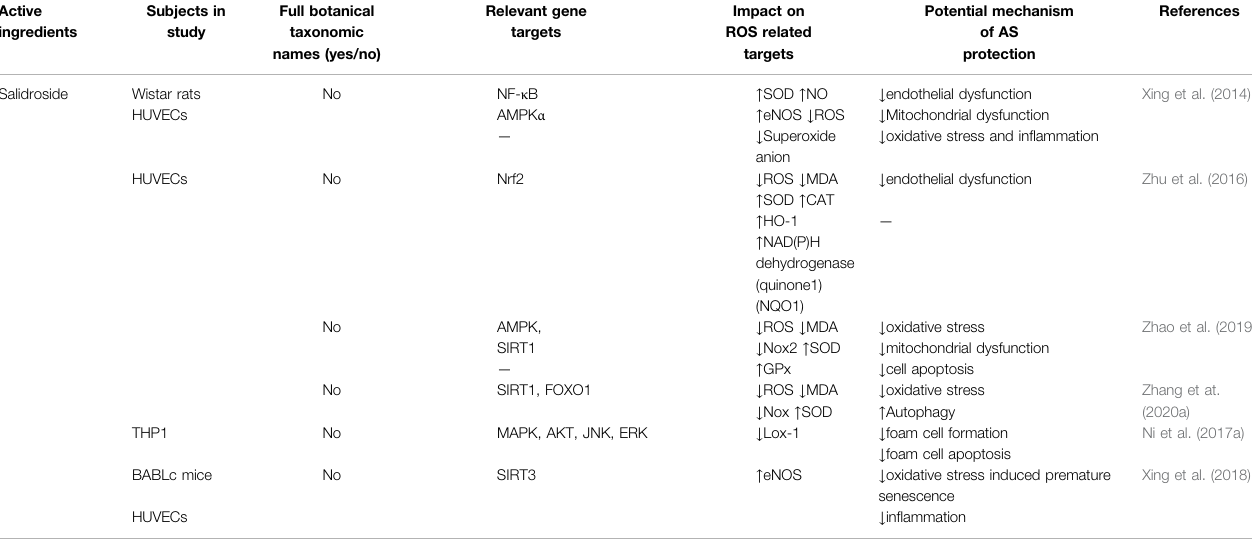
TABLE 3 | Salidroside for treatment of atherosclerosis by regulating oxidative stress. Active ingredients